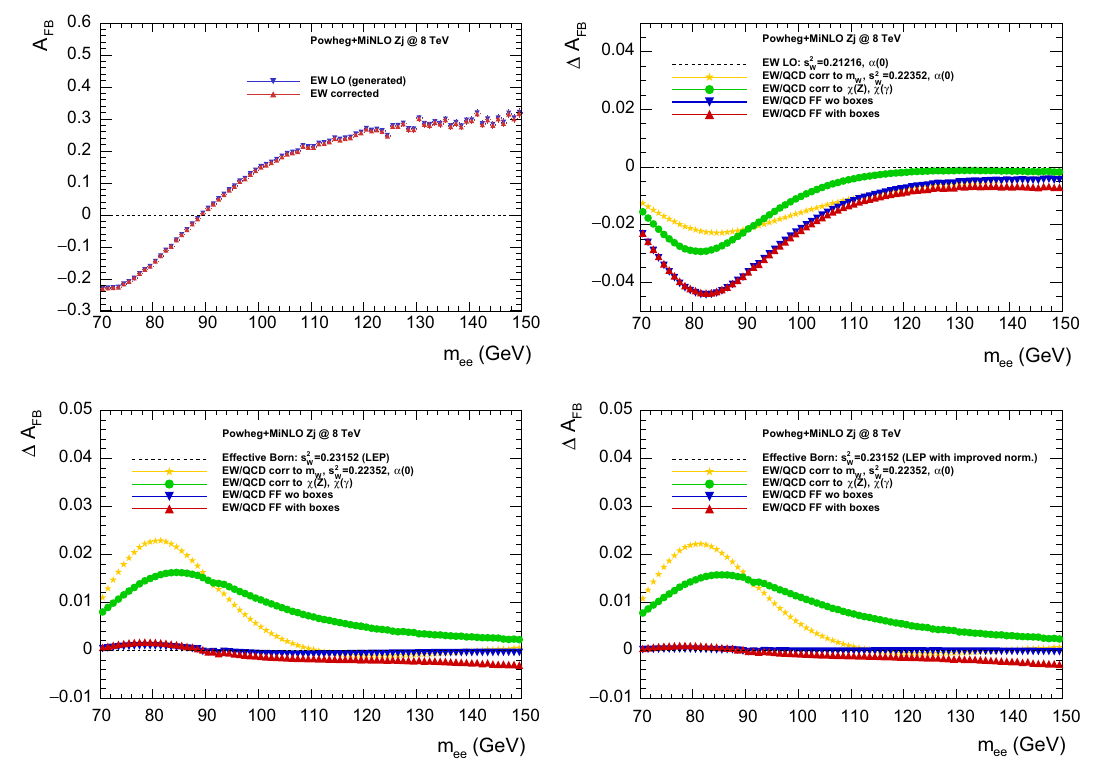
Fig. 5 Top-left: the A FB as generated with Powheg+MiNLO (blue triangles) and after reweighting introducing all EW corrections (red tri- angles). The two choices are barely distinguishable. The differences (cid:8) A = A − A ref , due to gradually introduced EW corrections FB FB FB